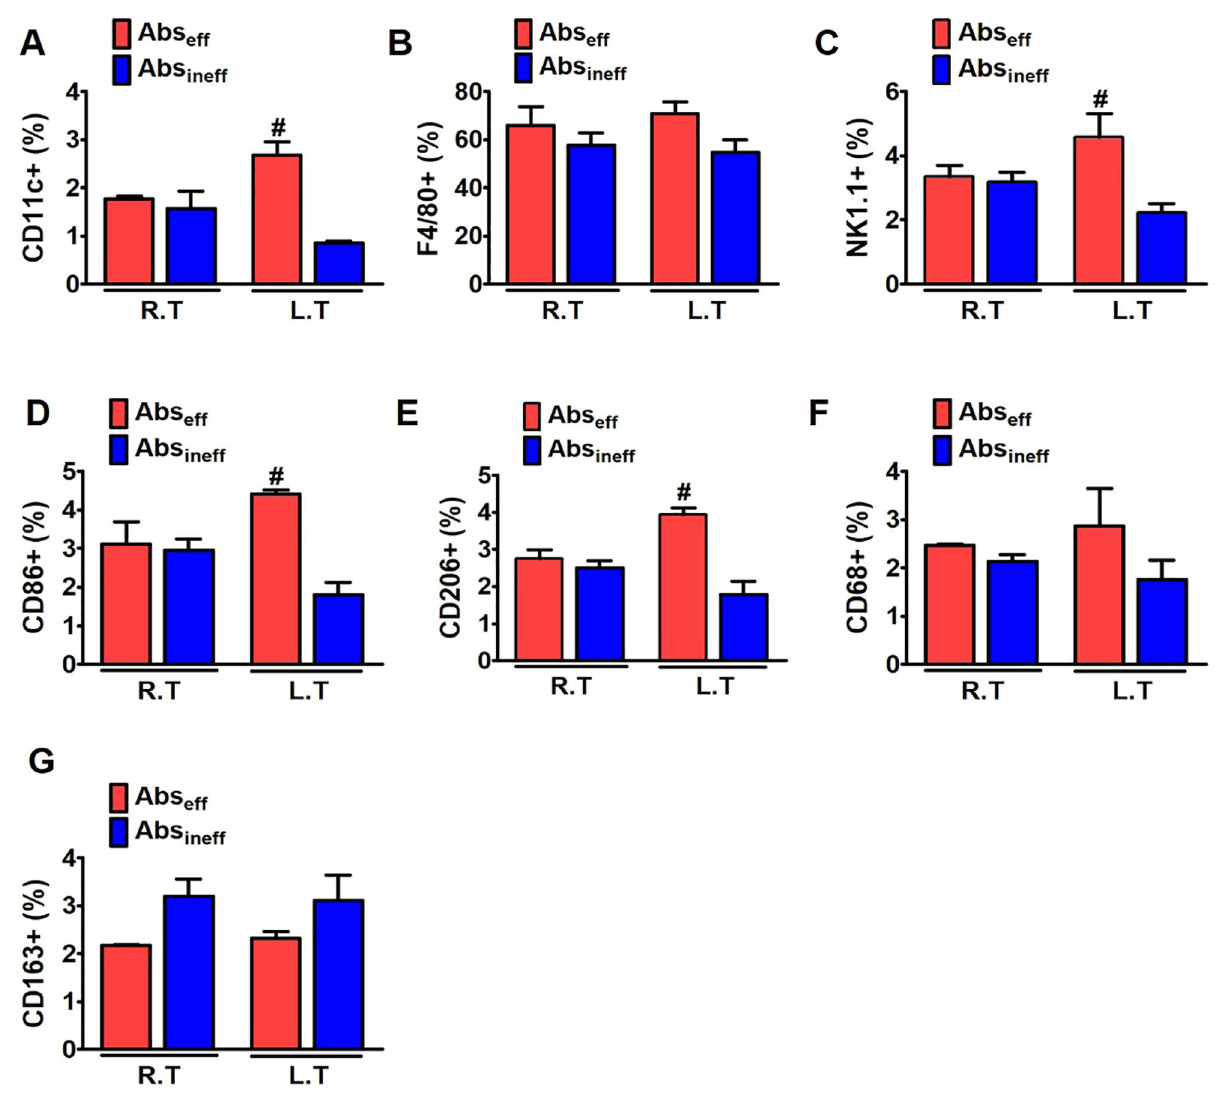
Figure 6. Flow cytometric analysis of the immune cells in the irradiated and non-irradiated tumor of pancreatic mouse tumors. Percentages of ( A ) CD11c + , ( B ) F4/80 + , ( C ) NK1.1 + ( D ) CD86 + ( E ) CD 206 + ( F ) CD68 + , and ( E ) CD163 + in (A) 24 and (B) 48 h from the irradiated and non-irradiated pancreatic tumor in the Abs eff group and Abs ineff group. Data are from an experiment representative of three mice in the effective and four mice in the ineffective group. * P < 0.05 compared to right tumor #P < 0.05 compared to left tumor (by one- way ANOVA with Tukey’s post hoc test for multiple